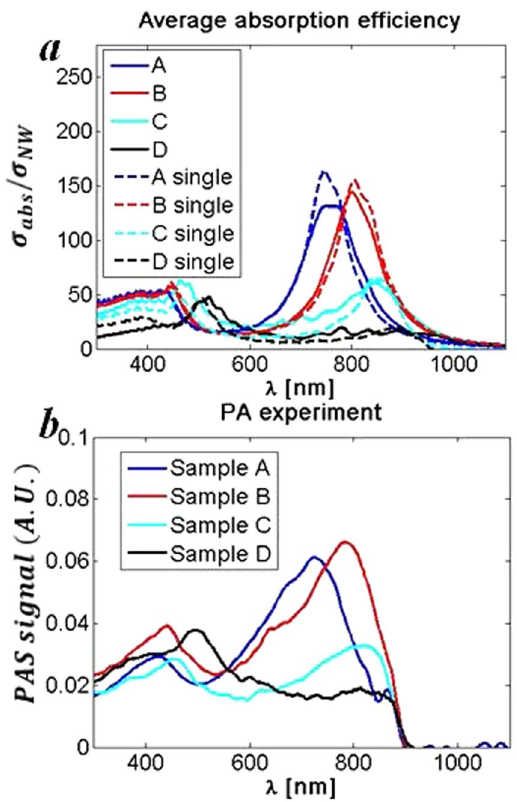
Figure 6. ( a ) Simulated average absorption efficiency including the actual NW size distribution for Samples A-D. Single NW simulations included for the sake of comparison. ( b ) PA spectra for Samples